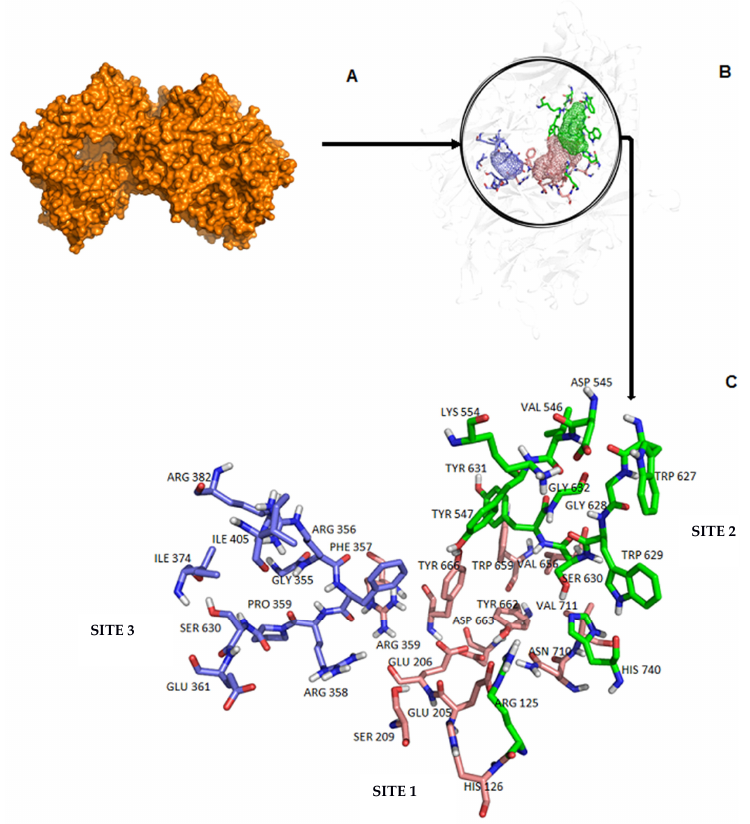
Figure 1. ( A ) Dimeric representation of the DPP-4 enzyme (PDB code: 4A5S [14,15]); ( B ) Representation of three binding sites of the DPP-4 enzyme found by FTSite [18–20] and FTMap [18,20–22] where regions 1 and 2 (colored in salmon and green, respectively) correspond to the active sites described in the literature (sites 1 and 2) and region 3 (colored in blue) is an alternative binding site (site 3) not described in the literature. ( C ) Key residues of the active site of DPP-4. Region 3 is a possible candidate as an allosteric binding site.